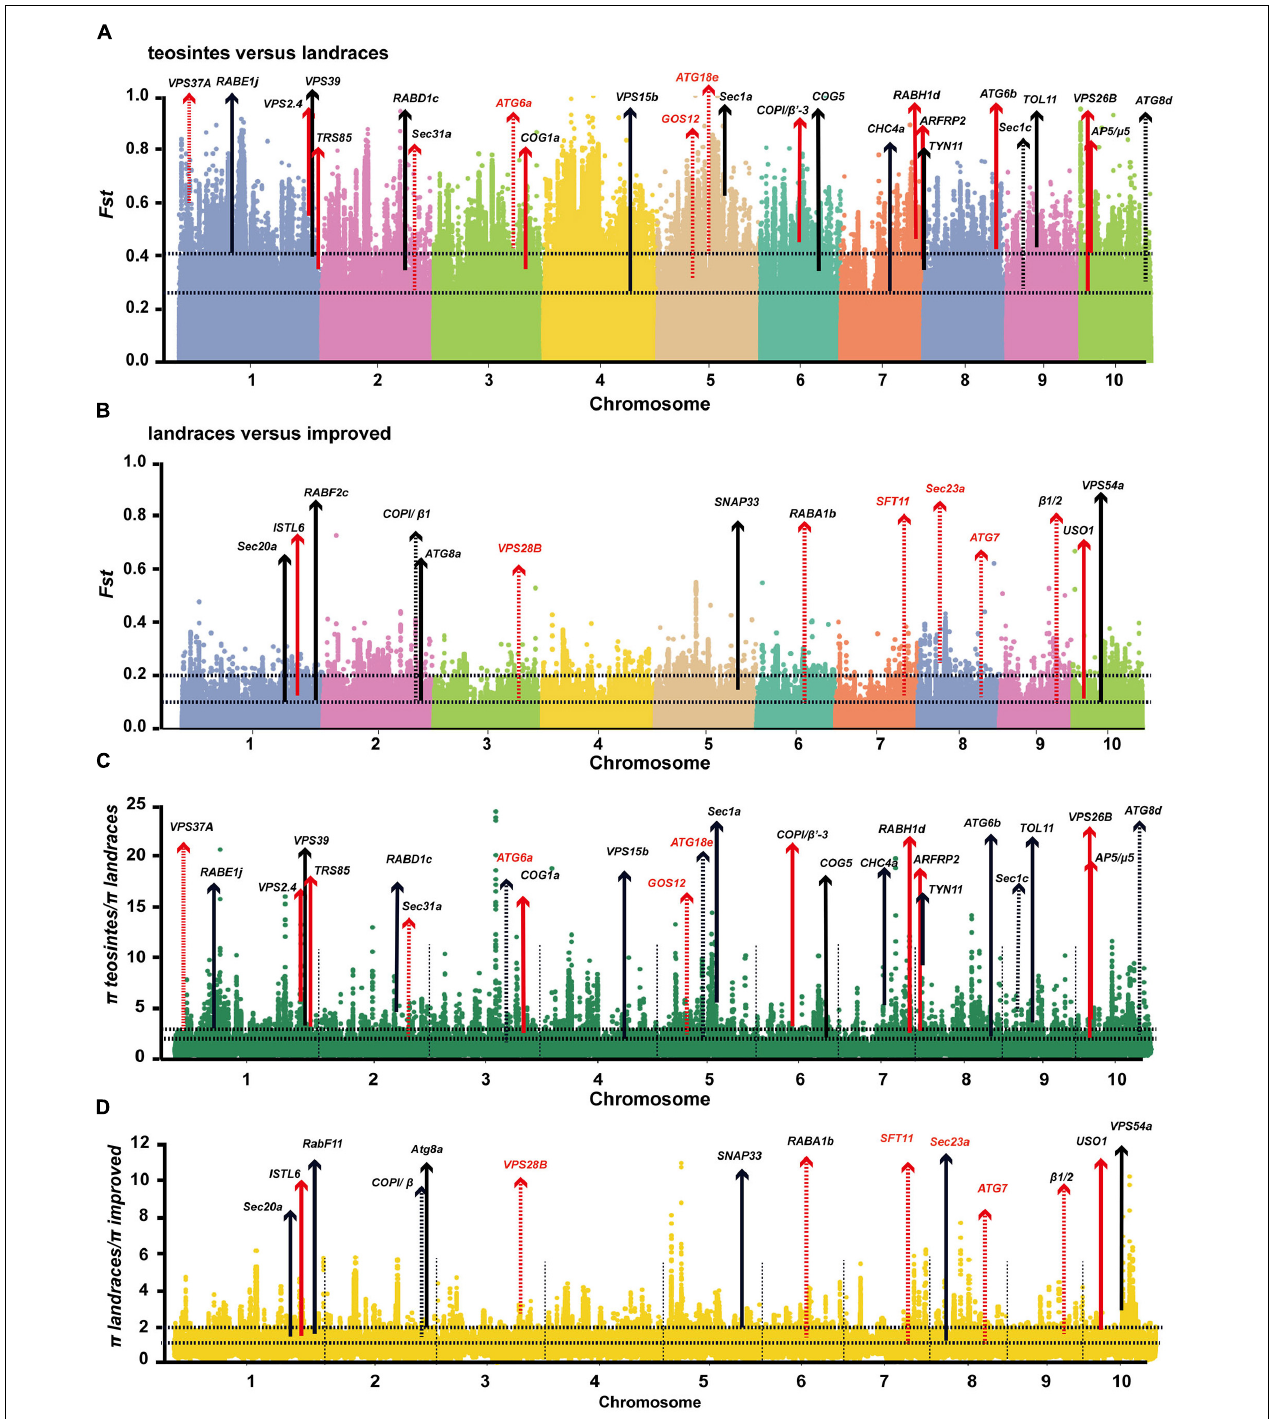
FIGURE 5 | Profiling of selected membrane-trafficking genes during maize domestication and improvement. (A–D) Genome-wide selective signals ( Fst and π ratio) analysis of teosinte, landrace, and improved using a 20-kb sliding window and 10-kb steps. The chromosome numbers are set along the x-axis. The top and bottom horizontal black dashed lines in each panel represent the top 1% ( Fst ≥ 0.41; π teosinte/ π landrace ≥ 2.56; Fst ≥ 0.14; π landrace/ π improved ≥ 1.99) and top 5% ( Fst ≥ 0.26; π teosinte/ π landrace ≥ 1.55; Fst ≥ 0.08; π landrace/ π improved ≥ 1.39) of cutoffs, respectively. Arrows indicate that membrane trafficking genes were selected during maize domestication and improvement. Red arrows represent these genes that have also been identified in previous evolutionary analyses (Hufford et al., 2012). Dashed lines indicate domestication or improvement of genes falling within the selected region. Solid lines indicate domestication and improvement